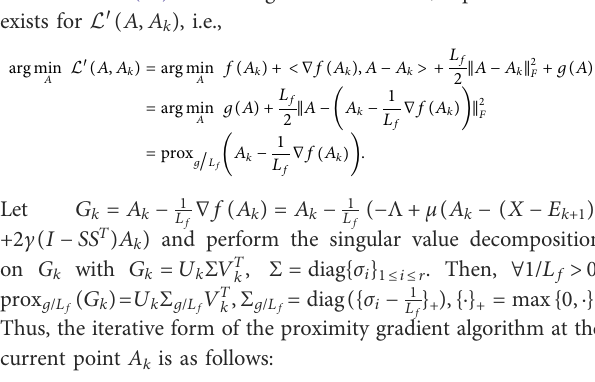
Algorithm 2. The Algorithm of solution for B , R with fi xed A , C ,